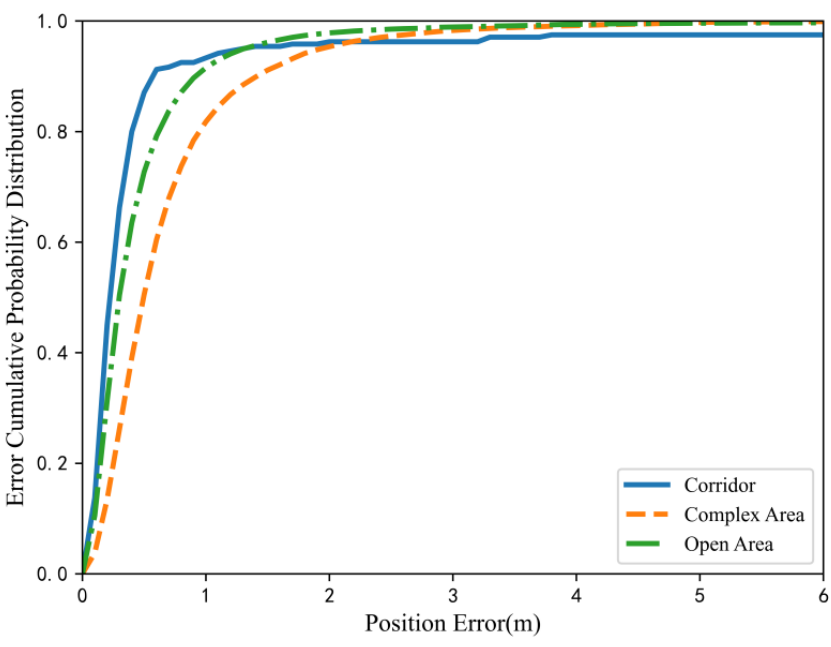
Figure 10. CDF of positioning errors in dissimilar regions.